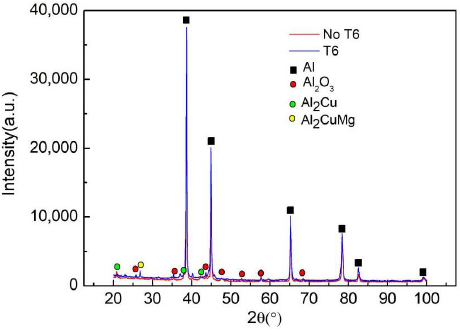
Figure 19. XRD analysis of rheoformed 2024 aluminum matrix composite component reinforced by 5 vol % Al 2 O 3 nanoparticles at 620 °C for 25 min stirring time before and after T6 heat treatment.